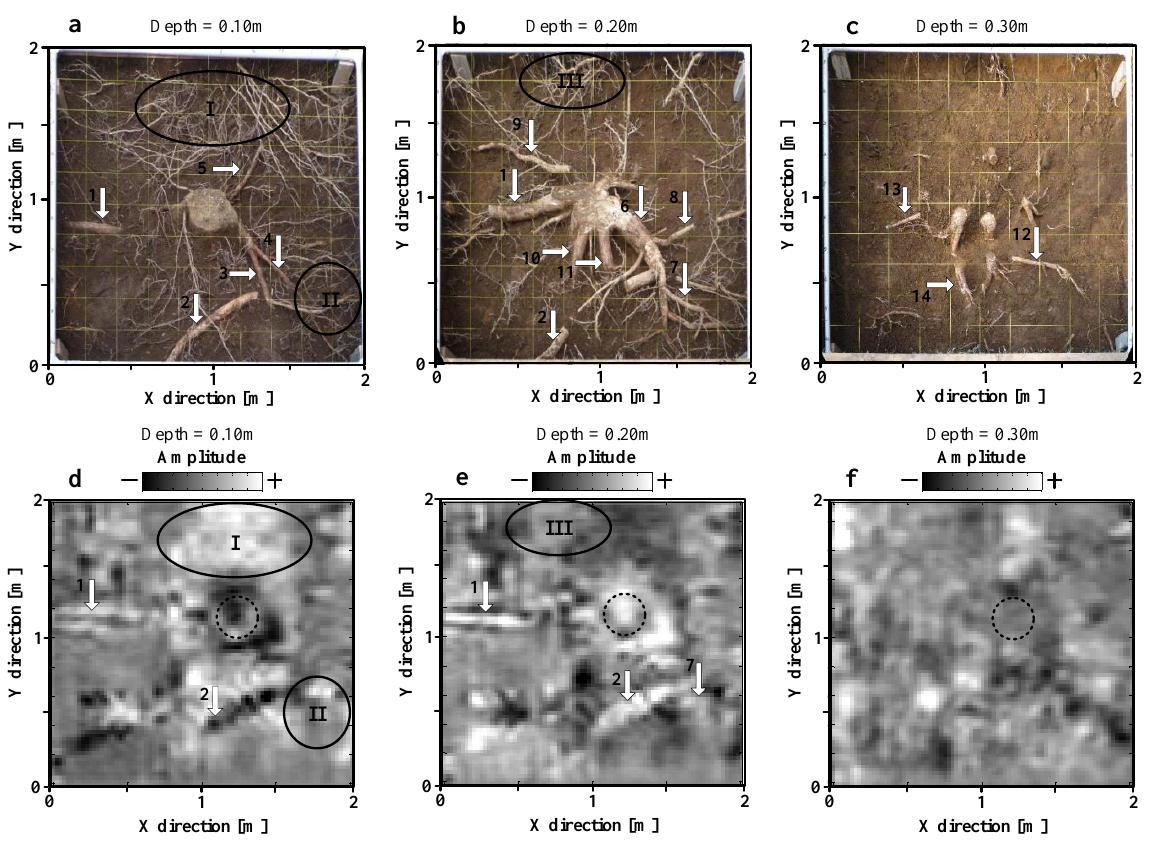
Figure 5. ( a – c ) True distribution scenes of one larch roots in 2.0 m × 2.0 m area, and each yellow grid represents the 20 cm × 20 cm area. After excavation at 10 cm depth each time, the exposed roots are cut off and their diameters and weights were measured